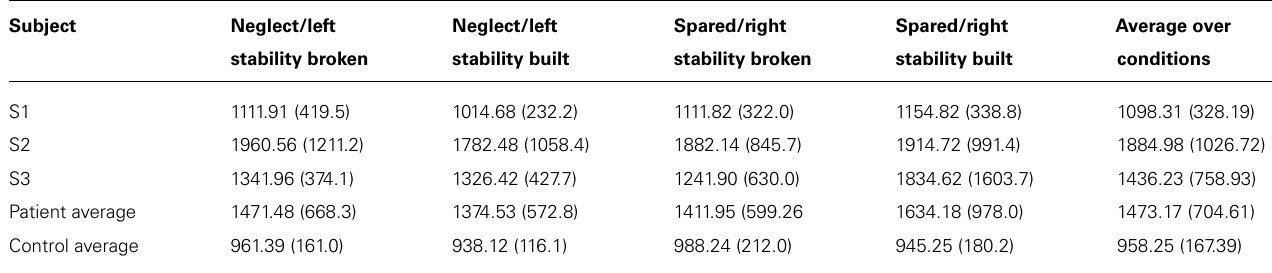
Table 2 | Mean correct response times and standard deviations (in parentheses) for each patient and the average of the 12 control participants in each of the four experimental conditions, as well as the average correct response times and standard deviations for each patient and for the control group across conditions (right columns), and the group averages for each condition across patients (second row from the bottom) and controls (bottom